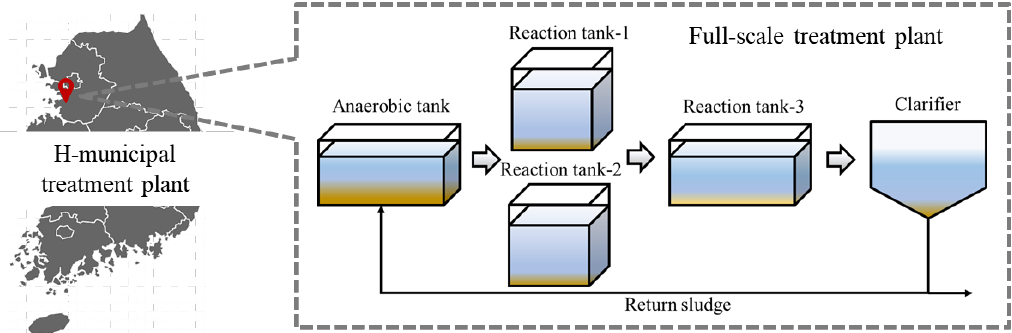
Figure 1. Conceptual configuration of the wastewater treatment plant.